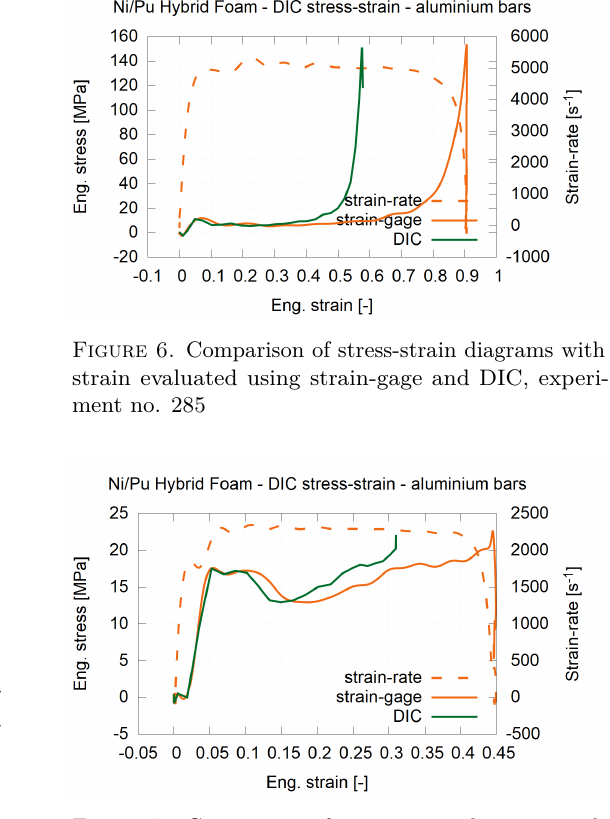
Figure 7. Comparison of stress-strain diagrams with strain evaluated using strain-gage and DIC, experi- ment no.